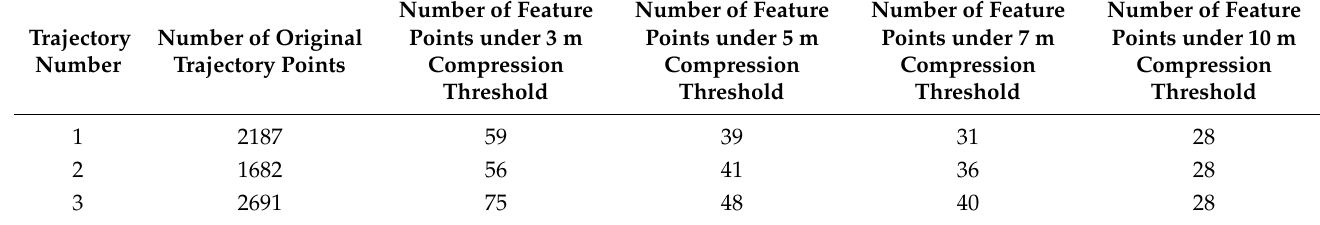
Table 1. Extraction results of Turning feature points under different compression thresholds.